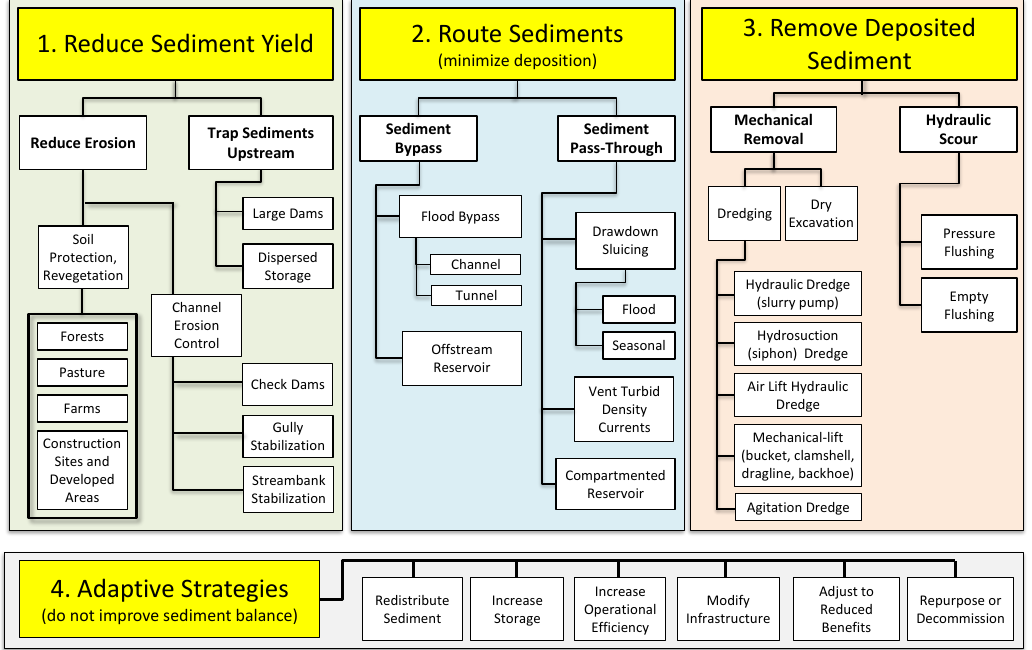
Figure 2. Classification of strategies for managing reservoir sedimentation and its consequences, using flow lines to show categories and